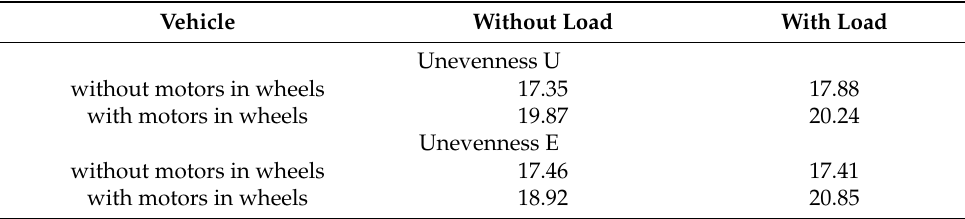
Table 1. List of IRI indicators determined from the road tests ( υ = 12.5 kmh − 1